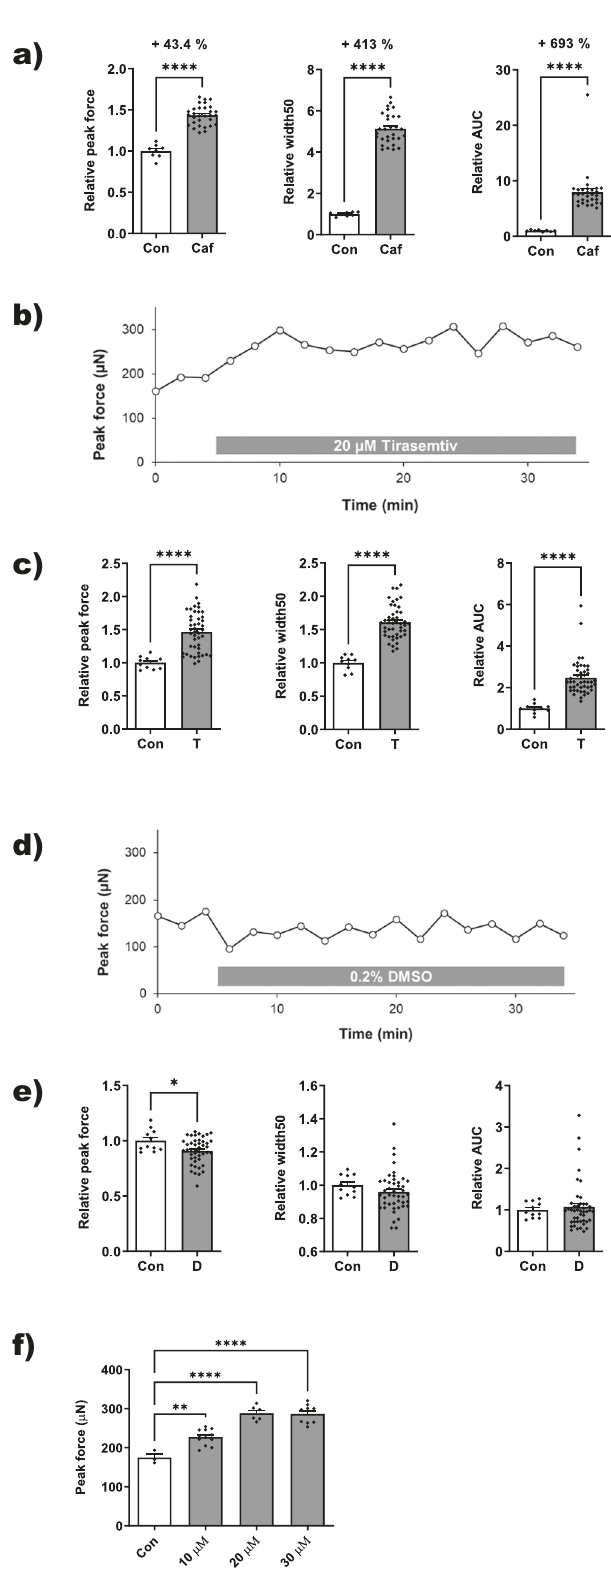
stiffness and models from many more donors at different age will be required to analyze the relationships between post de fl ection with respect to stiffness, tissue differentiation, model rupture and different donor age. To date, most in vitro engineered skeletal muscle tissue models are made of fi brin-containing Matrigel hydrogels 12,40 – 42 , even though fi brin is not a natural component